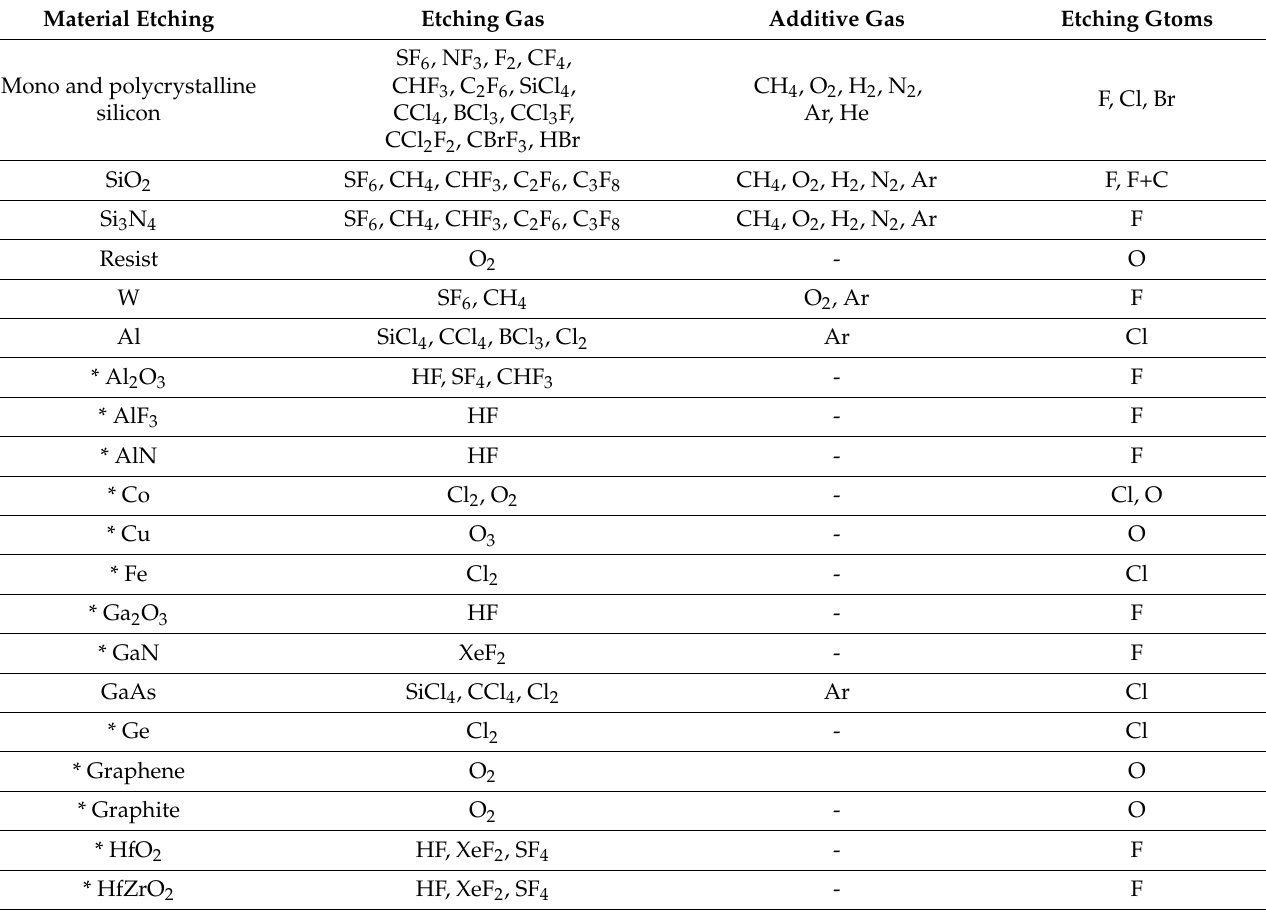
Table 3. List of chemical materials used in conventional plasma etching and plasma atomic layer etching. Material Etching Etching Gas Additive Gas Etching Gtoms Mono and